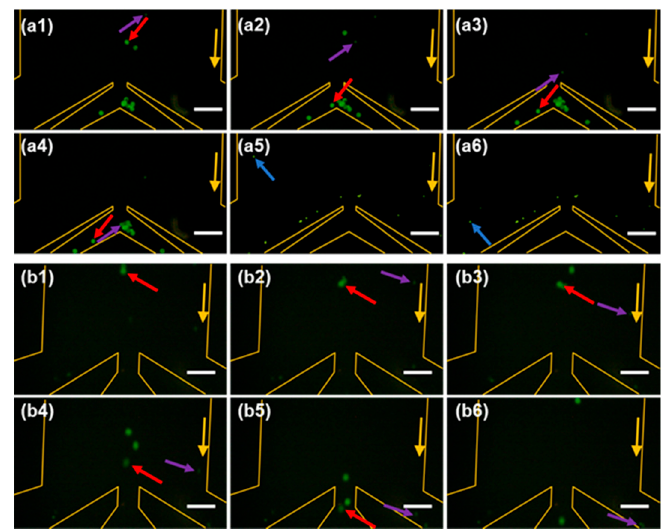
Figure 8. Snapshots of the movement of immunomagnetic beads at the outlet at the first stage ( a1 – a6 ) and the second stage ( b1 – b6 ). The 10 μ m, 20 μ m and 40 μ m magnetic beads are indicated by blue, purple and red arrows respectively. Yellow arrows indicate the flow direction. The time interval is approximately 2 s. Scale bar is 200 μ m.